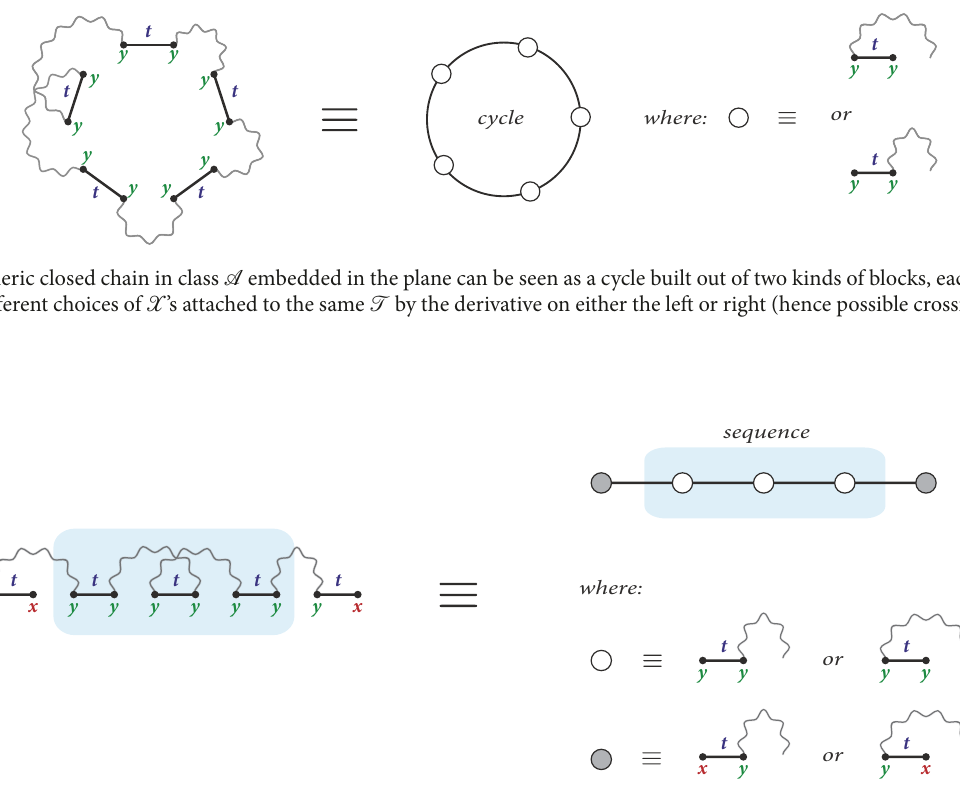
Figure 4: If embedded in the line, each open chain in B forms a sequence whose inner part (in the grey box) is built out of blocks of type Y 2 T with two blocks of type XYT attached at the ends. Here again, each block can have two configurations due to different choices made by the derivatives (possible crossings of the wavy